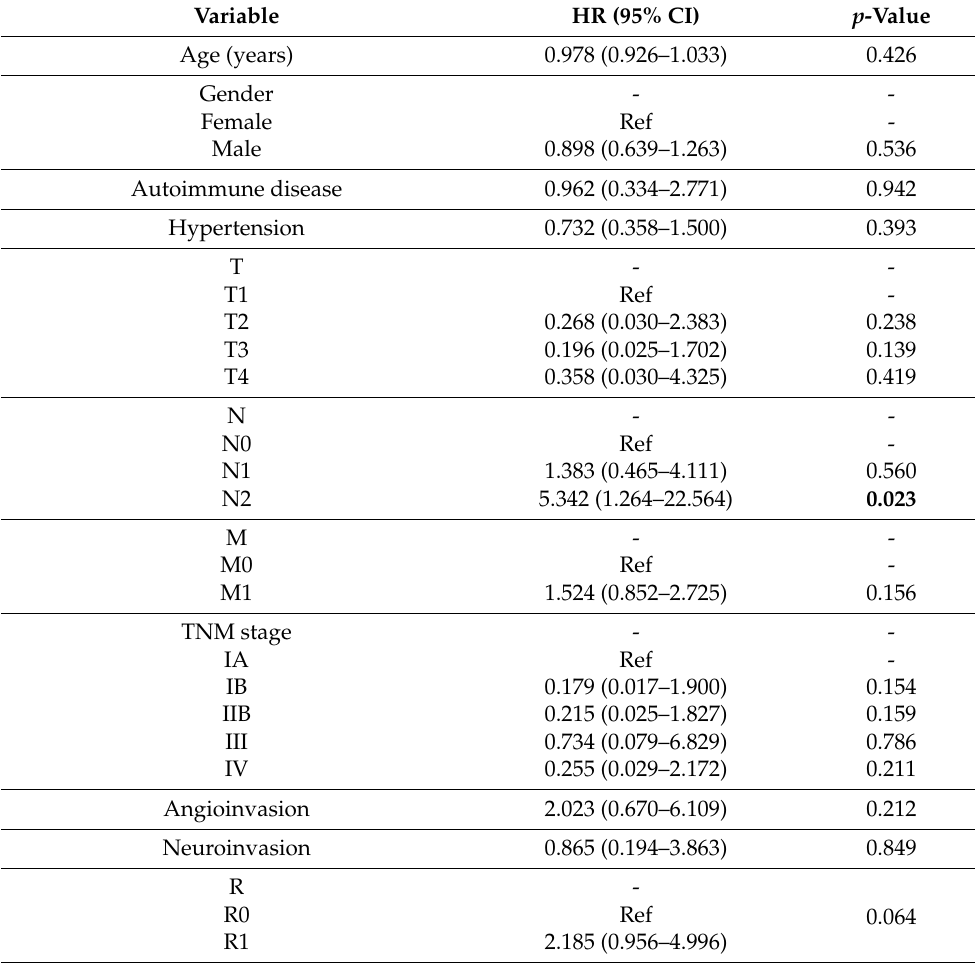
Table 5. Univariate analyses of prognostic factors for overall survival—T2DM